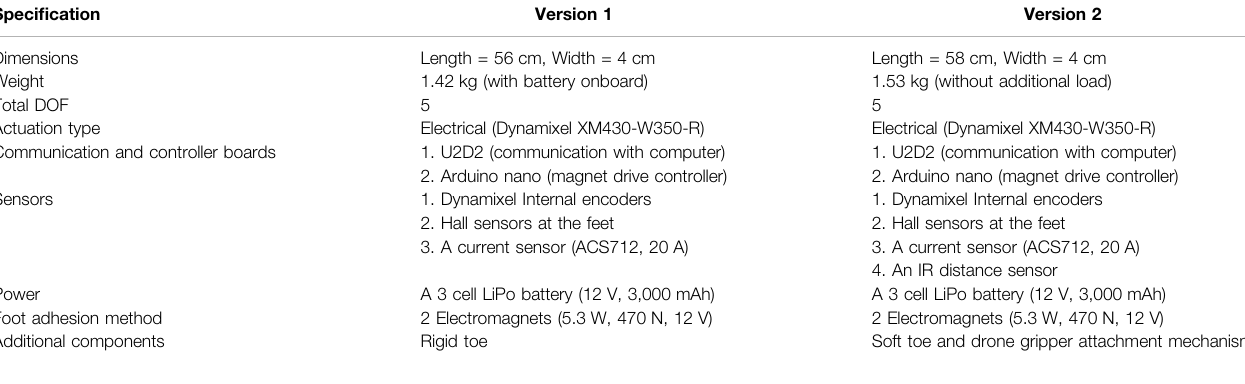
TABLE 1 | Comparison of the speci fi cations of the two versions of the robot. Version 1 was reported in Khan et al. (2020) whereas version 2 is reported in this article. Speci fi